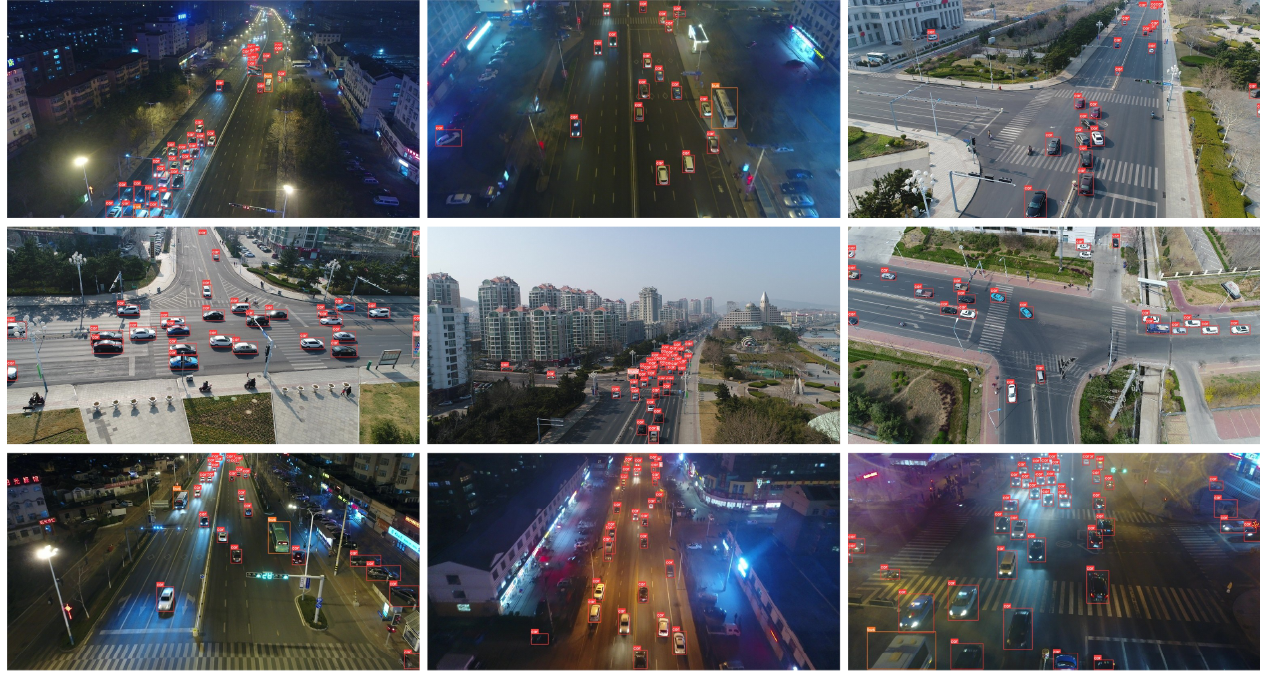
Figure 10. Qualitative results of the proposed TPH-YOLOv5++ on the UAVDT